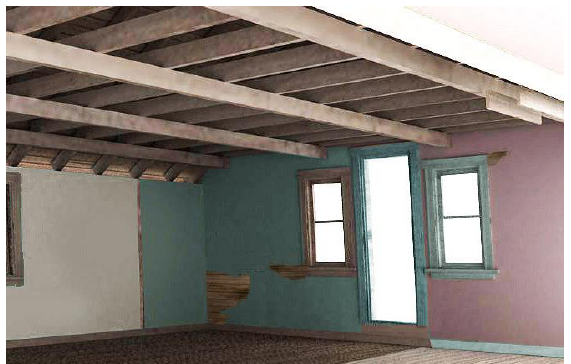
Figure 8: Photorealistic reconstruction of the second floor of the laundry shop. Source: Peter